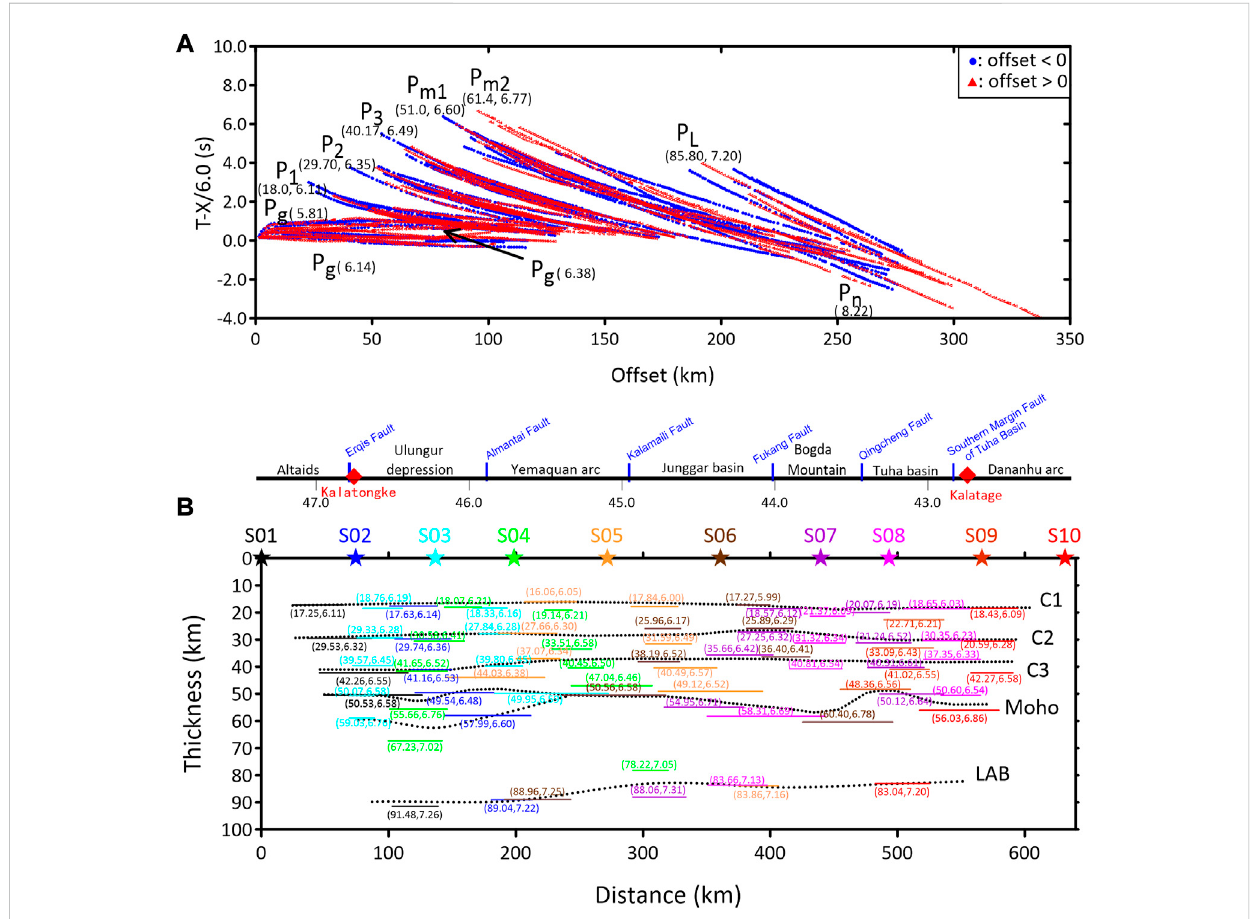
FIGURE 3 (A) Traveltime-offset curves on a reduced time scale by velocity of 6.0 km/s. In parentheses: re fl ection depths and P-wave velocities deduced from the seismic phases previously identi fi edon each record section. Both the observed data (blue dotted lines) and the calculated data from the fi nal velocity model(redtriangles)have also beenincludedfor furthercomparison. (B) Spatial distribution ofback-projectedvelocities,depthsand possible re fl ections (dotted lines) based on the X 2 -T 2 method. Top: structures and faults traversed by the pro fi le; red diamonds mark the location of the Kalatongke and Kalatage mineral deposits to the north and south of the pro fi le,